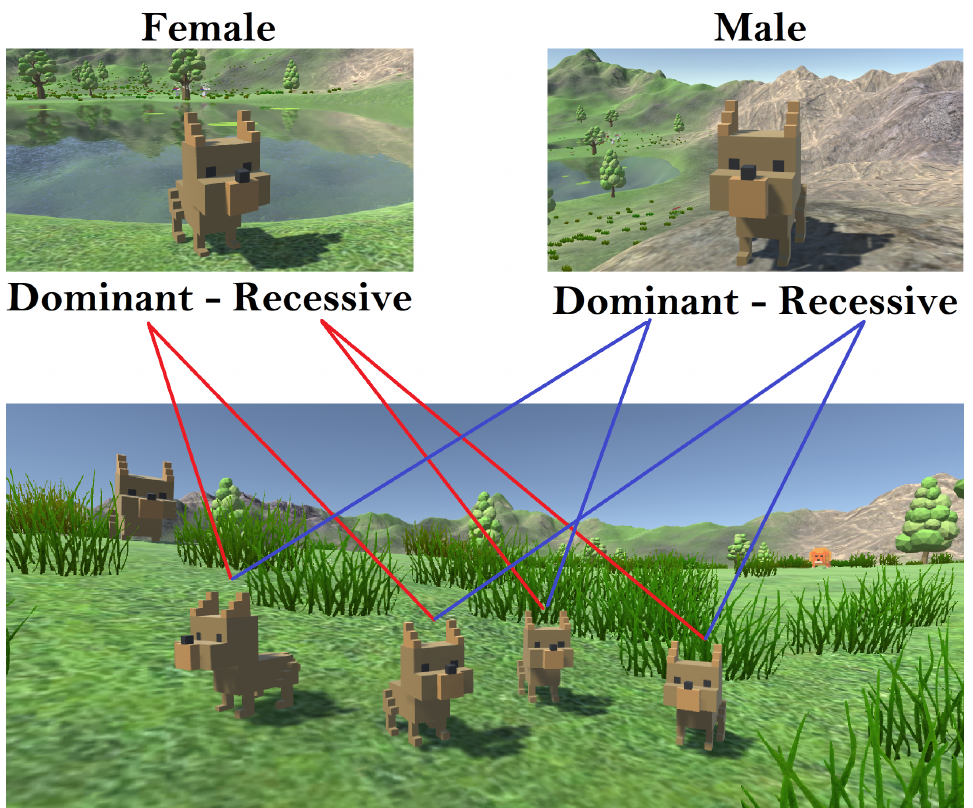
Figure 14. The picture illustrates a simple dominant–recessive inheritance pattern with one of the default animal models in the